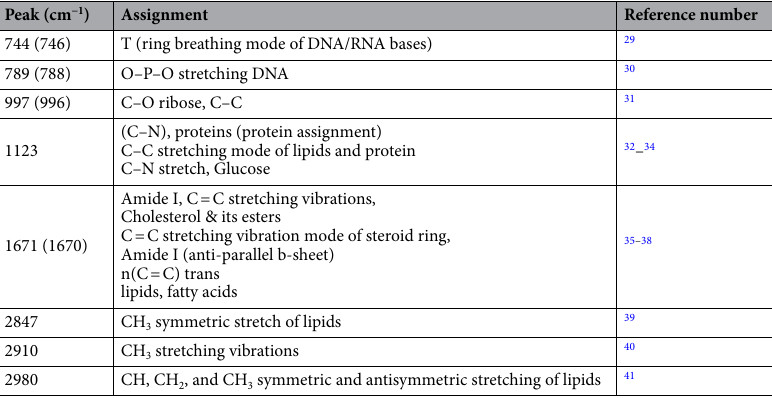
Table 1. Assignment of specific Raman bands to vibrational models and biological molecules 28